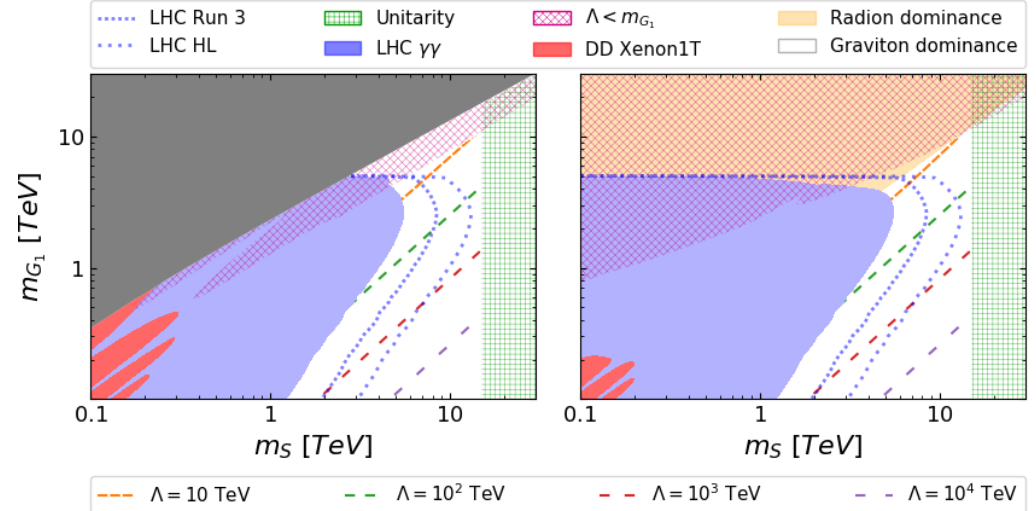
Figure 10 . Region of the ( m h (cid:27)v i = h (cid:27) i . Left panel: the radion S ; m G 1 ) plane for which FO v and the extra-dimension stabilization mechanism play no role in DM phenomenology. Right panel: the extra-dimension length is stabilized with the Goldberger-Wise mechanism, with radion mass m r = 100 GeV. In both panels, the grey area represents the part of the parameter space where it is impossible to achieve the correct relic abundance; the red-meshed area is the region for which the low-energy RS e(cid:11)ective theory is untrustable, as (cid:3) < m G ; the wiggled red area in the lower left 1 corner is the region excluded by DD experiments; the blue area is excluded by resonant KK-graviton p searches at the LHC with 36 fb (cid:0) 1 at s = 13 TeV; the dotted blue lines represent the